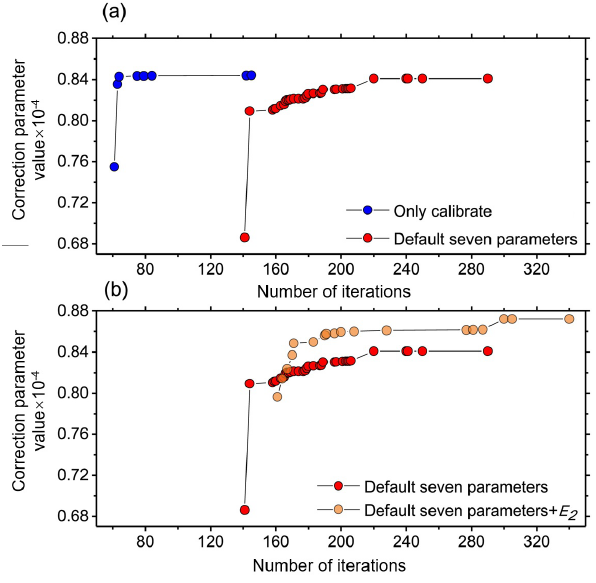
Fig. 3 Parameter (I 2 , I 9 , I 12 , I 20 ) iterative